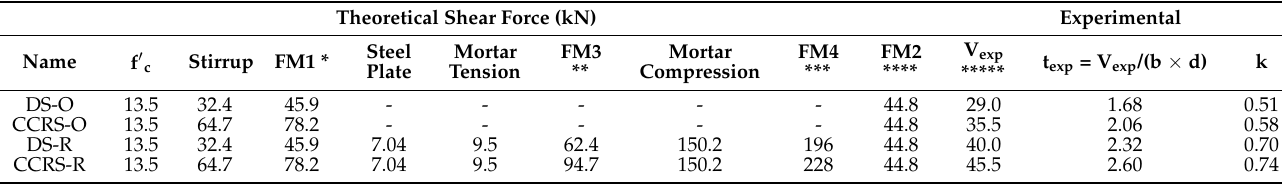
Table 9. Theoretical capacities of the